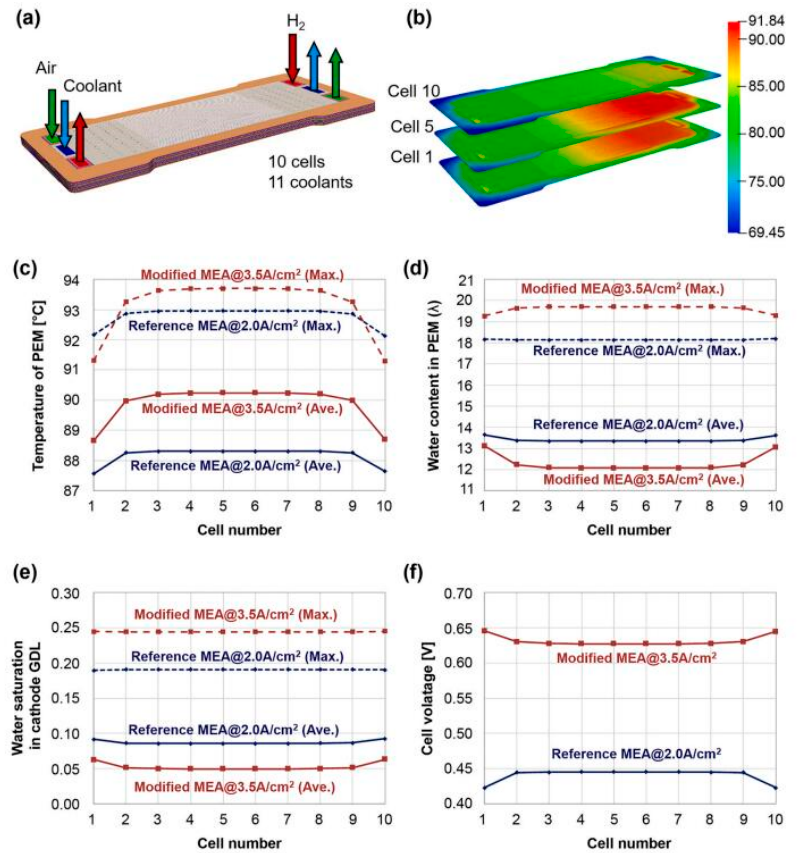
Figure 13. Influence of diffusivity and thermal conductivity of GDL gas on temperature and water saturation distribution of PEM; ( a ) gas/coolant flow direction; ( b ) temperature distribution of middle and terminal cells for the modified MEA at 3.5 A/cm 2 ; ( c ) temperature of PEM; ( d ) water content of PEM; ( e ) water saturation in cathode GDL; ( f ) cell voltage [100].